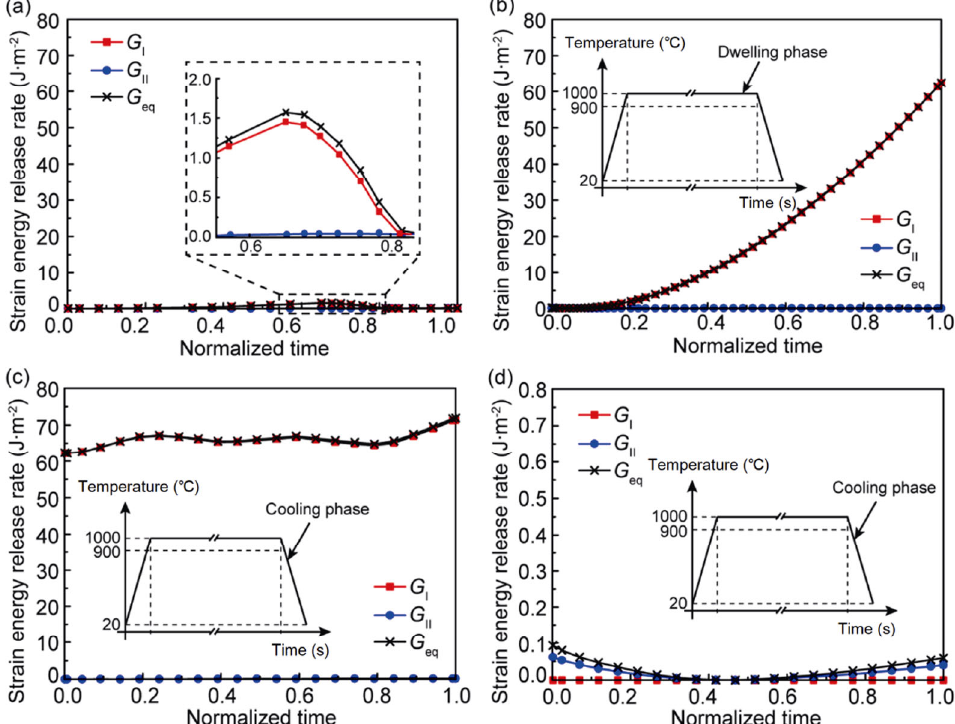
Fig. 24 Evolution of strain energy at the crack tip under different stages during one thermal cycle: (a) heating stage, (b) dwelling stage, and (c, d) cooling stage. The models only in (a)–(c) contain the TGO growth. Reproduced with permission from Ref. [133], © ASM International